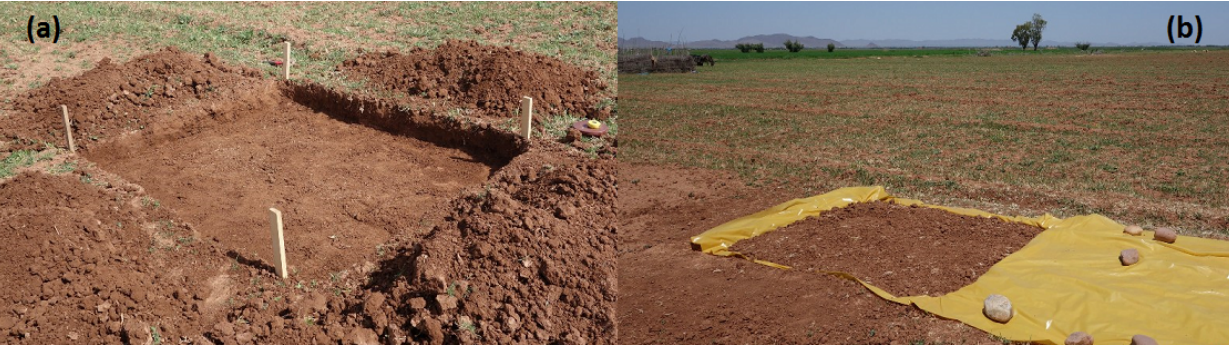
Figure 2. Illustration of the dry soil plot in the R3 perimeter. ( a ) The pit was dug at a 15-cm depth and ( b ) the soil plot was kept fully dry by covering it with a plastic sheeting in between experiments.